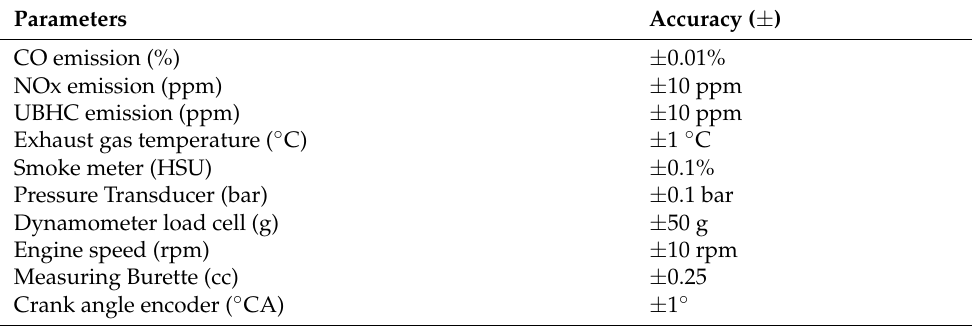
Table 6. Accuracy levels of engine